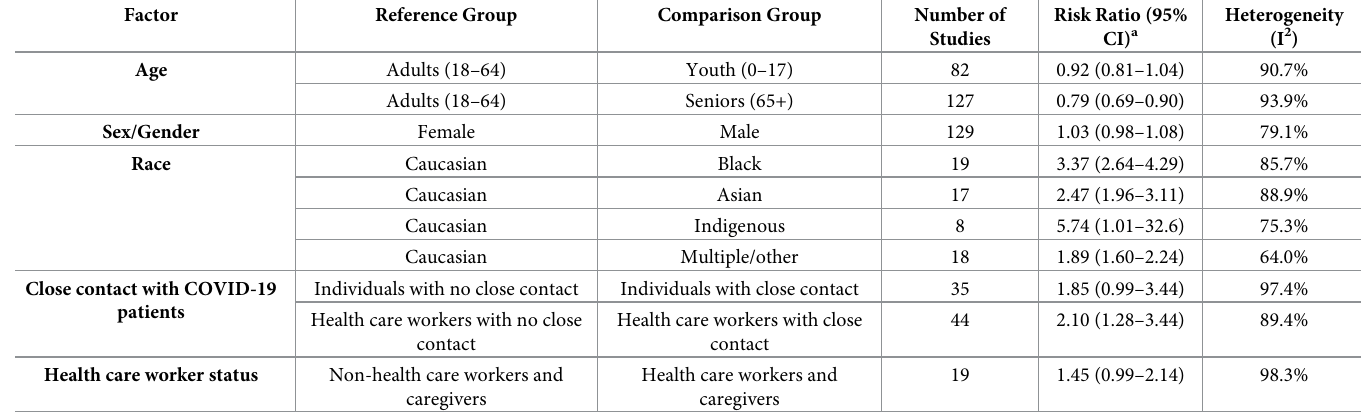
Ratio of seroprevalence to cumulative case incidence The median ratio between corrected seroprevalence estimates from national studies and the cor- responding cumulative incidence of SARS-CoV-2 infection nine days prior was 18.1 (IQR 5.9– 38.7, n = 49 studies; Table 6, S2 Fig in S1 Materials), indicating a median of 18.1 serologically identified infections per 1 confirmed case globally. Stratifying by risk of bias and GBD showed variation in median ratios between seroprevalence and cumulative incidence (Table 6).